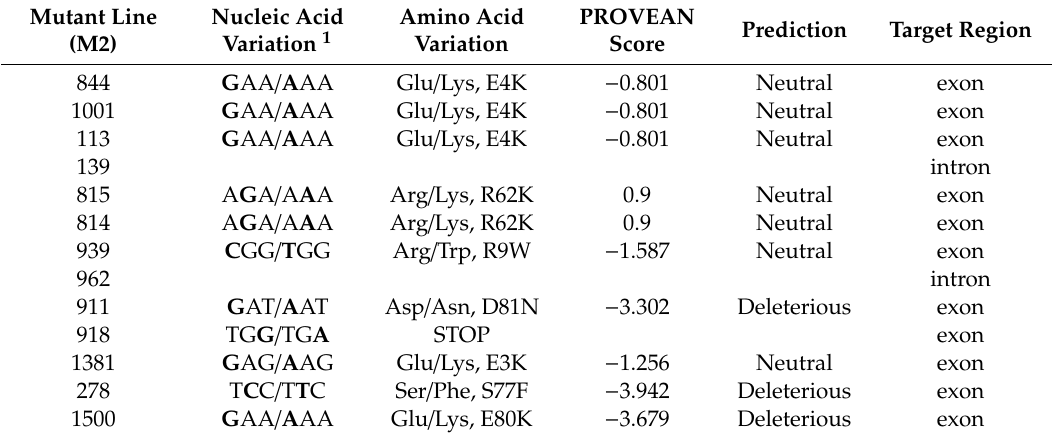
Table 1. Functional e ff ect of amino acid substitution predicted by the PROVEAN web server. Mutant